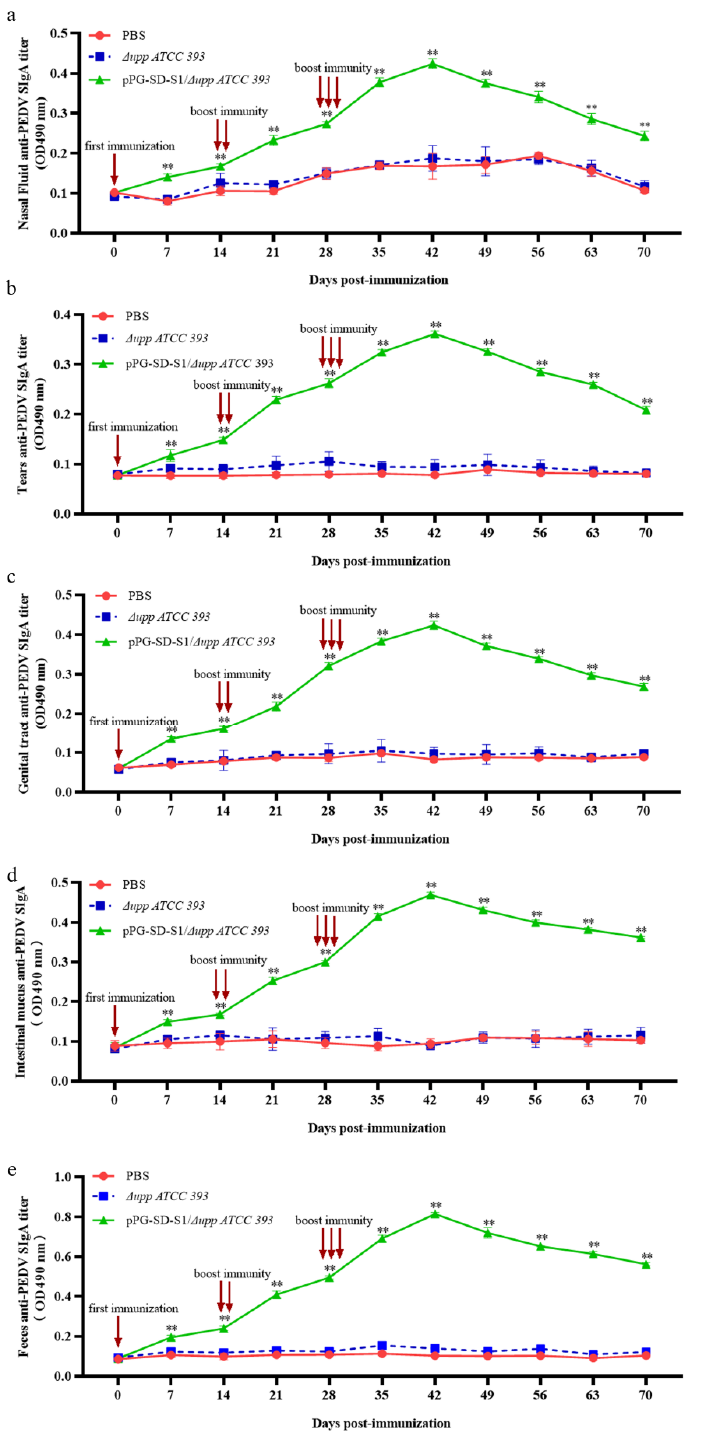
Figure 5. The changes in anti-PEDV-specific SIgA antibody levels in the nasal fluid ( a ); tears ( b ); reproductive tract mucus ( c ); intestinal mucus ( d ); and feces ( e ) of immunized mice. The intestinal mucus was gently scraped from the excised intestinal tissue with HEPES buffer, and 0.1 g of feces was added to 400 µL of 1 mmol/L phenylmethylsulfonyl fluoride and 1% BSA. After incubation and centrifugation, the supernatant was stored at − 40 °C until use. The anti-PEDV SIgA levels were measured using indirect ELISA. (** p < 0.01 compared to the control groups: PBS and Δ upp ATCC 393 ).